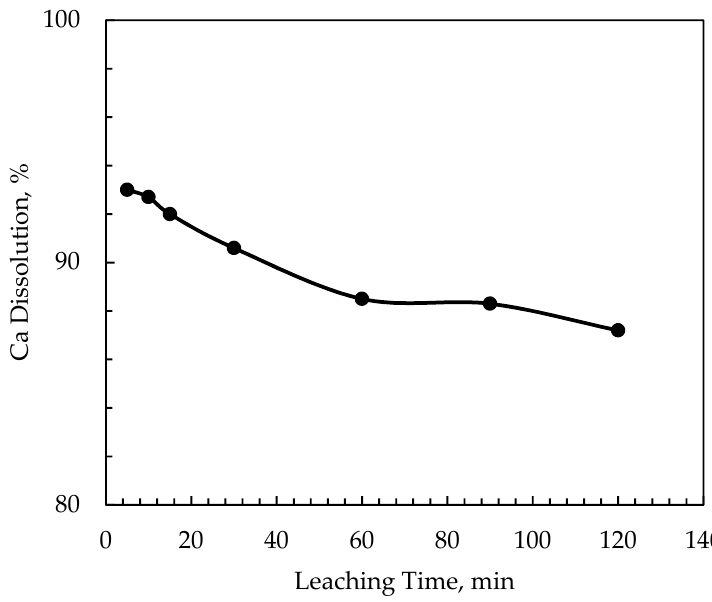
Figure 10. Calcium dissolution curve at different leaching times.